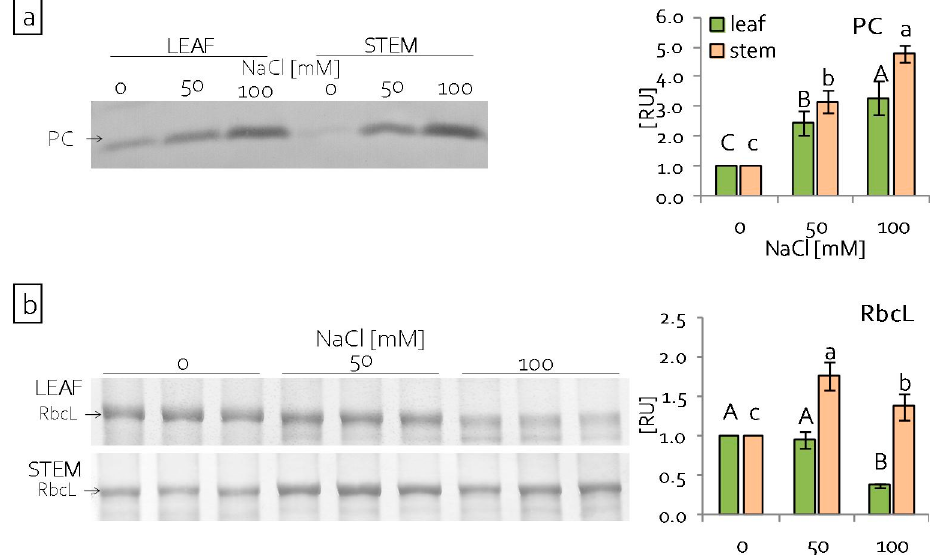
Figure 6. Content of ( a ) plastocyanin (PC) and ( b ) large subunit of RuBisCo (RbcL) of grass pea leaf and stem photosynthetic apparatus under salinity; content of proteins expressed as relative units [RU]; different letters—statistically significant differences within each organ (leaf-uppercase, stem-lowercase) at p ≤ 0.05; ( n = 3).